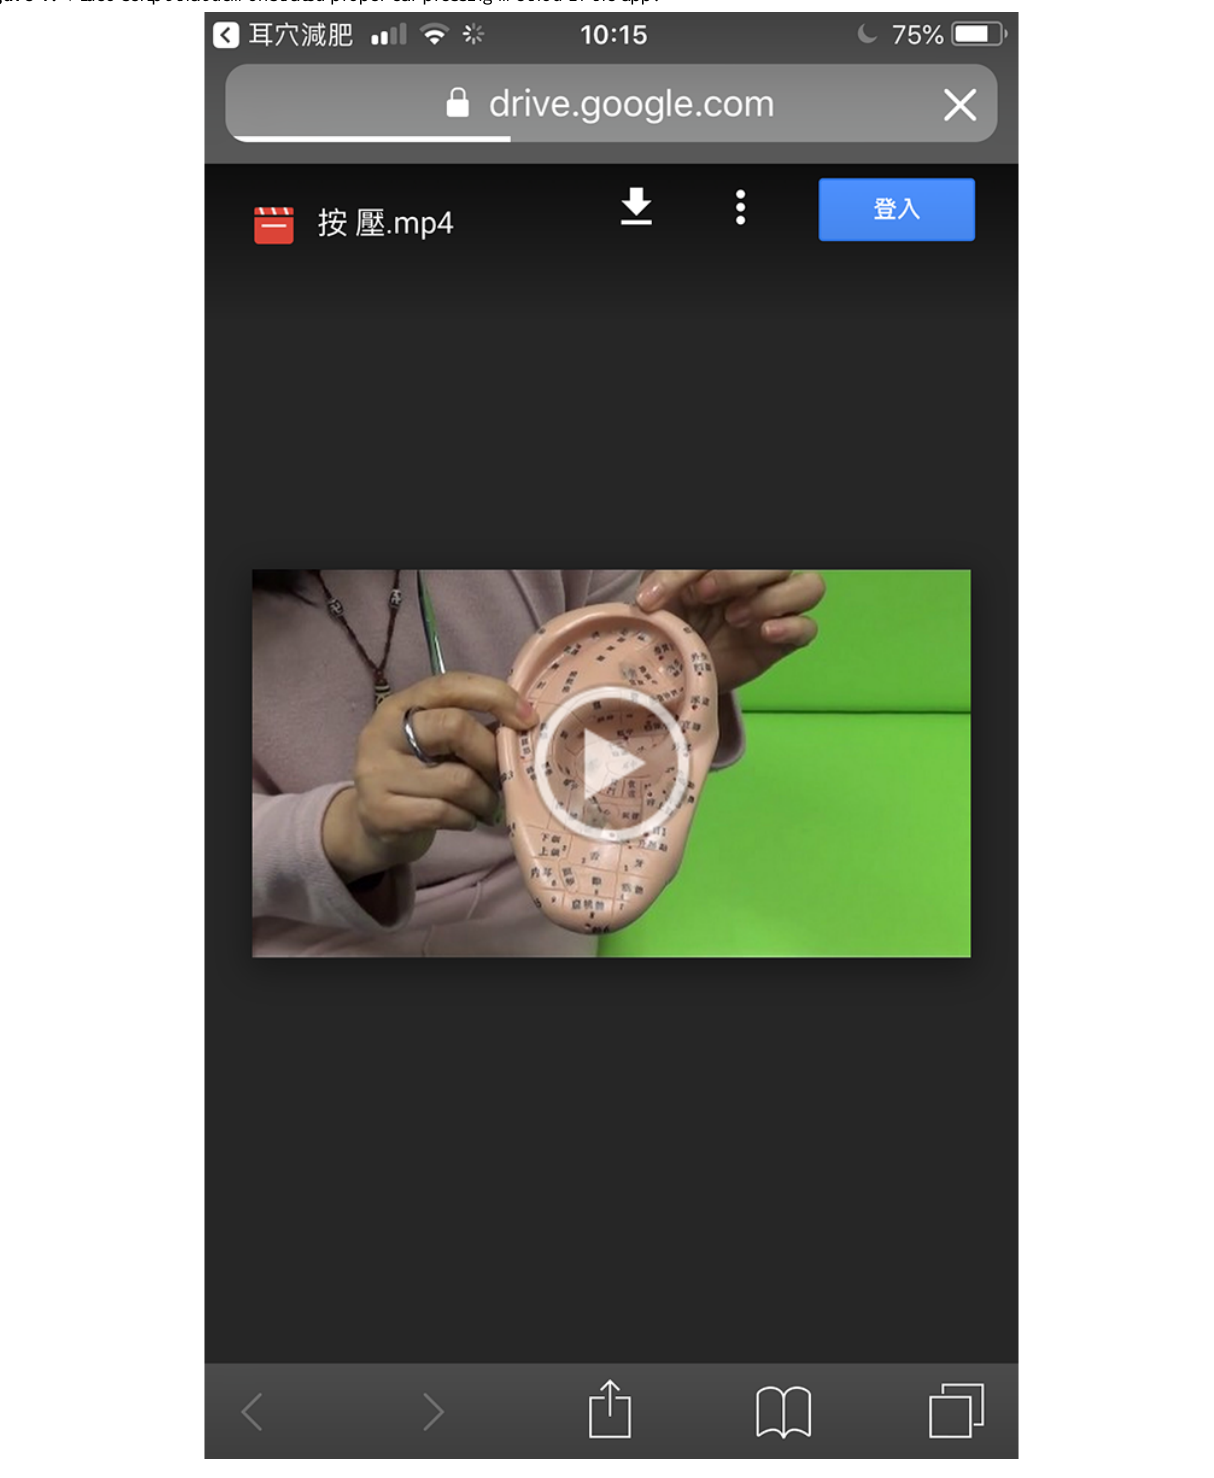
Figure 4. Video script that demonstrated proper ear pressing method in the